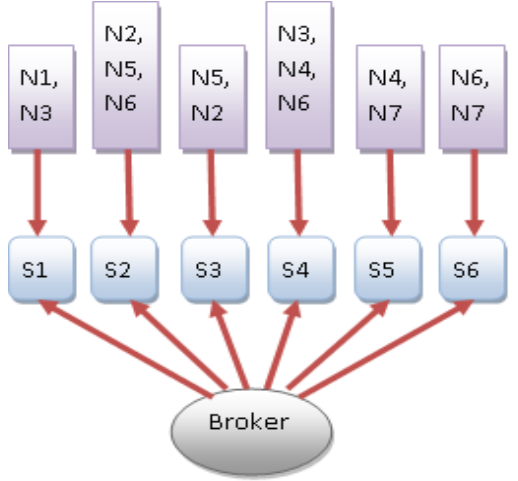
Figure 2. Selection of broker based on its services.